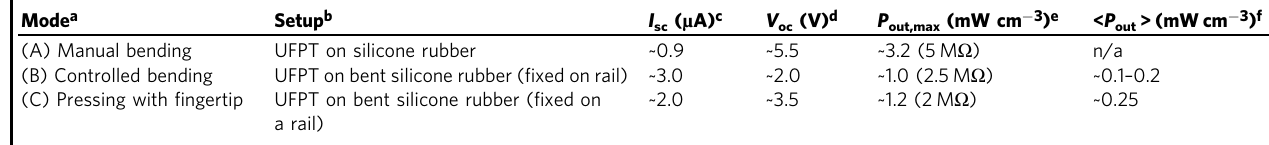
a Operation mode; b layer setup used; c I sc : short-circuit current; d V oc : open-circuit voltage; e measured output power density P out for optimum load resistance (denoted in bracket) at ~2Hz excitation frequency; the active UFPT volume is A ∙ D trans = 5.63×10 − 4 cm 3 , whereby A is the active transducer area of 2.25cm 2 and D trans is the total transducer thickness of 2.5 µ m; f the mean generated power density < P out >is calculated by P = E Δ t − 1 , whereby E is the harvested energy stored in the capacitor C and is de fi ned by E = ½ CV dc 2